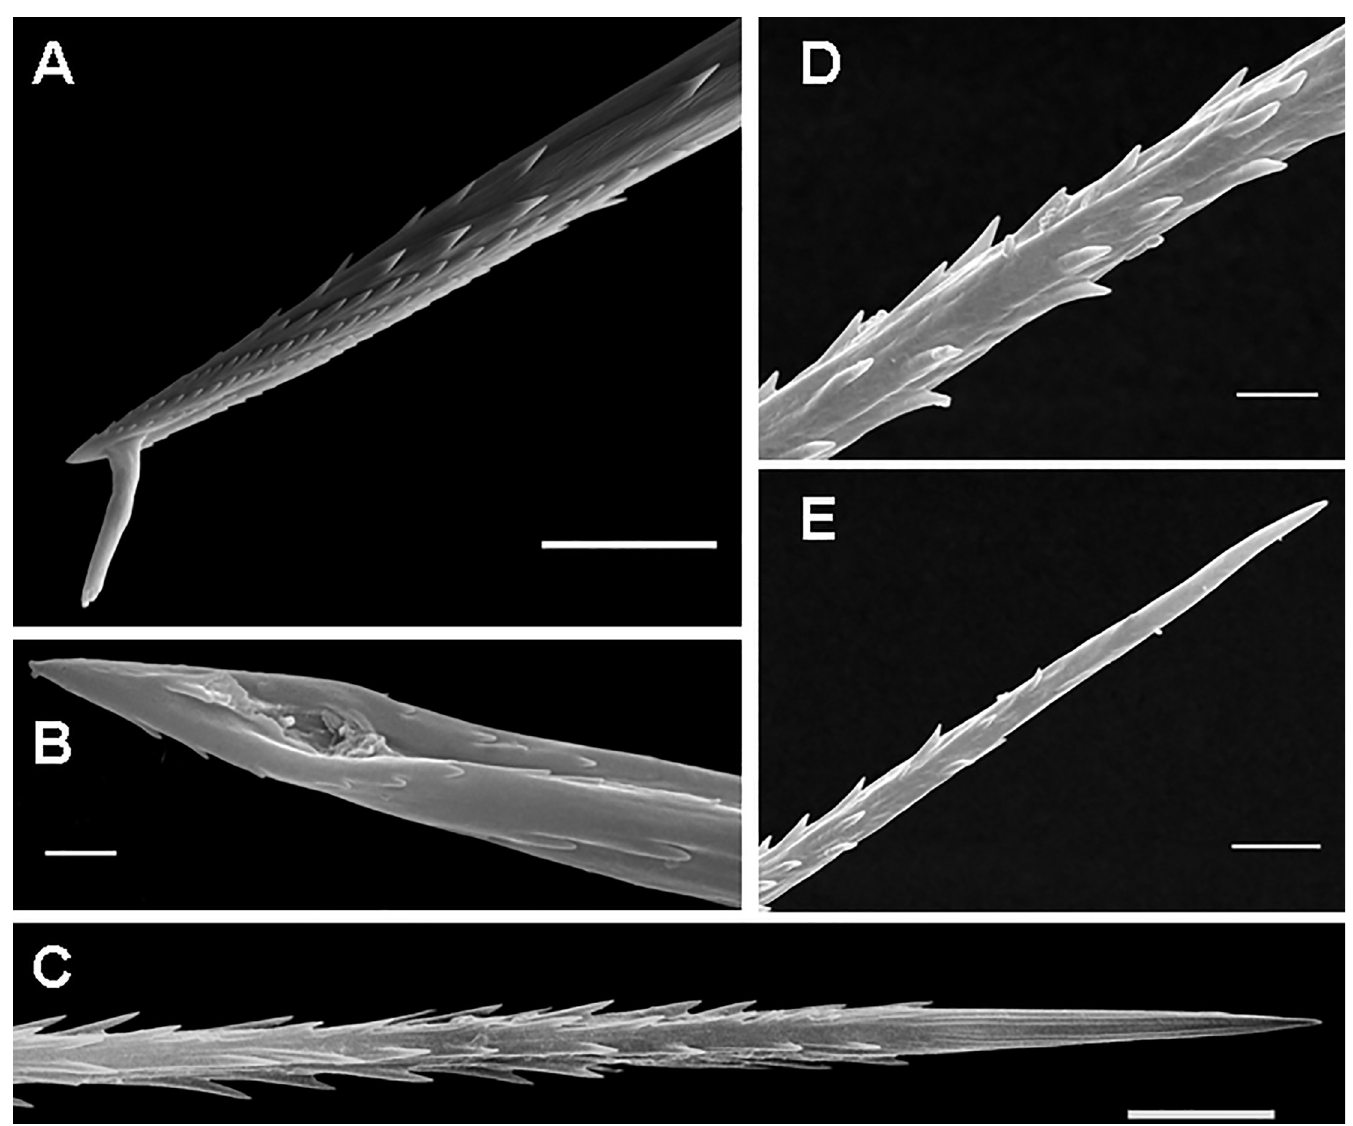
Fig 7. Urticating setae of type II. (A) Avicularia sp., female from Beni province, Bolivia. Type II, basal section with a supporting stalk. Scale bar = 20 μ m. (B) Caribena versicolor , juv. (car. 3.5). Type II, basal section. Scale bar = 2 μ m. (C) Caribena versicolor , male. Type II, apical section. Scale bar = 10 μ m. (D) Caribena versicolor , juv. (car. 2.5). Type II, midsection. Basal part on the left. Scale bar = 5 μ m. (E) Caribena versicolor , juv. (car. 3.5). Type II, apical section. The basic morphology of urticating setae in juveniles is identical to mature specimens, but the barbs are less developed. Scale bar = 10 μ m. Abbreviations: juv. = juvenile specimen; car. = length of